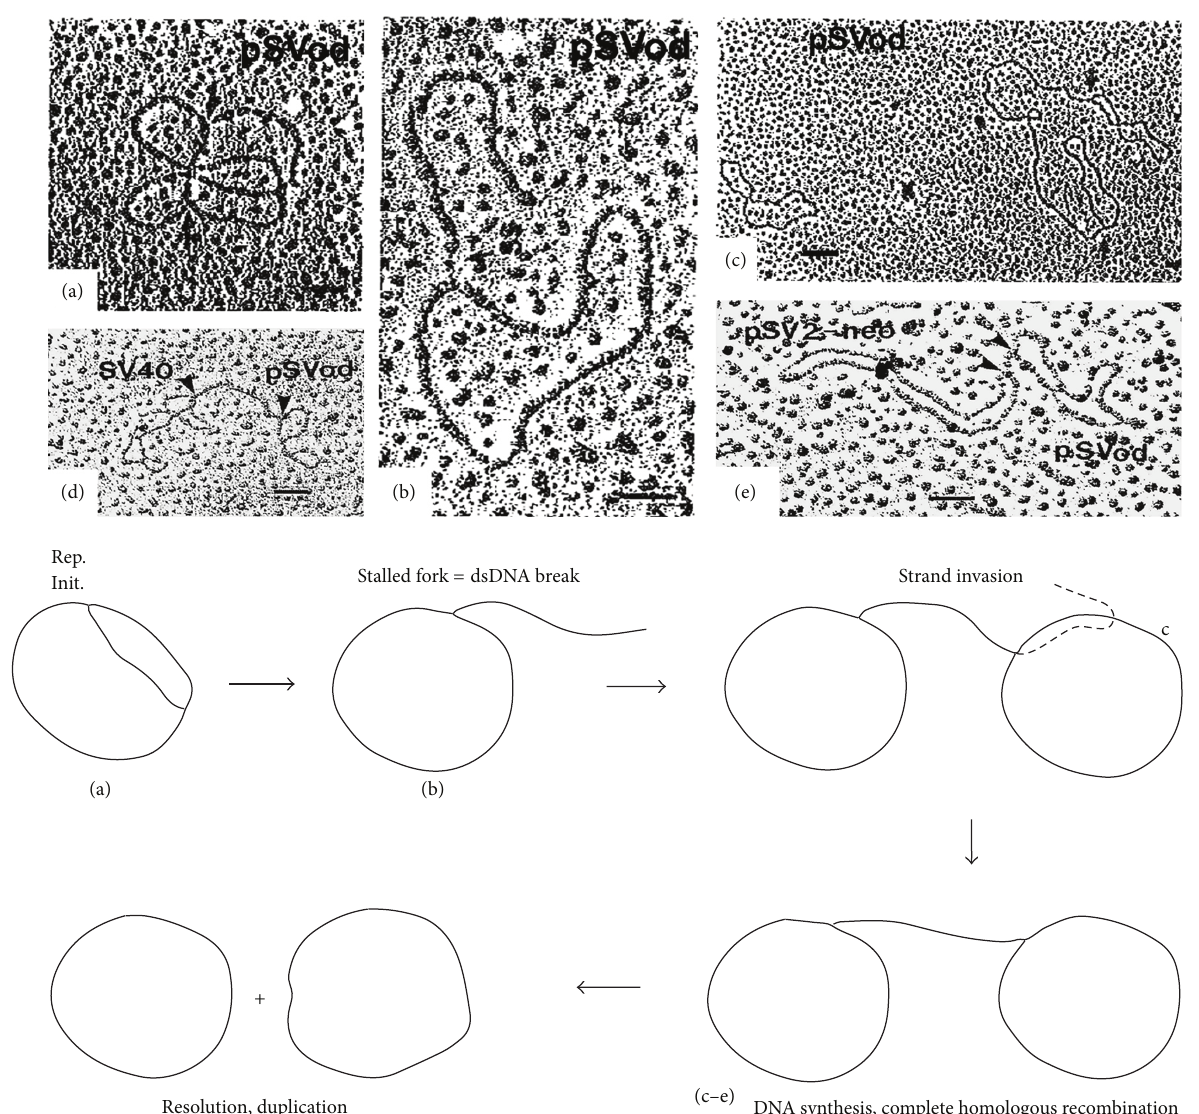
Figure 3: Recombination between replicating plasmids or viral DNA bearing an SV40 ori sequence. Electron micrographs showing in vitro replication of plasmids pSVod (3.3 kb), pSV2-neo (5.6 kb), or SV40 (5.2 kb) are reprinted from Jenab and Johnson [74] with permission from Elsevier. (a) A theta form with replication forks indicated by arrows. (b) A theta form with a dsb creating a free DNA end. (c) Two pSVod circles connected by a DNA bridge. (d) A DNA bridge (arrows) indicating recombination between plasmid pSVod and SV40 viral DNA. (e) A DNA bridge indicating recombination between plasmids pSVod and pSV2-neo. No dual-circular forms or theta forms were seen in the absence of either an SV40 ori or large T-antigen. The drawing at bottom depicts potential dual circular recombination generated by dsb followed by strand